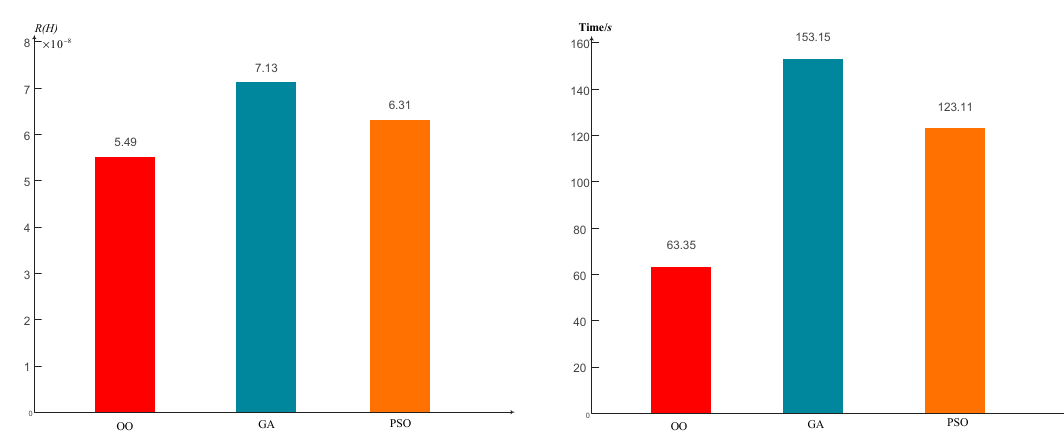
Figure 4. Comparison of Accuracy and Operation Time between Different Algorithms.